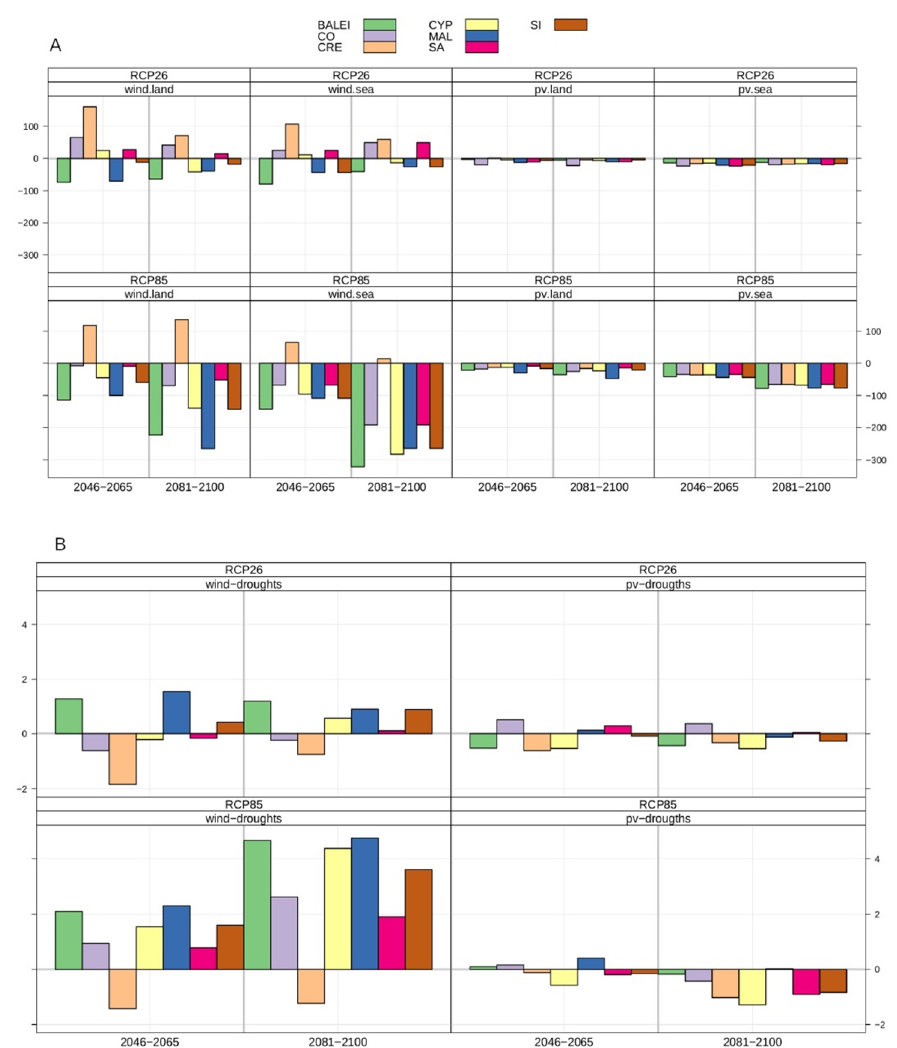
Figure 3. ( A ) Ensemble mean changes of annual wind (solar) productivity in absolute terms (kWh/kW) for the RCP2.6 and RCP8.5 scenarios and different periods over the sea and over the land. ( B ) Ensemble mean changes of annual wind (solar) productivity droughts in absolute terms (i.e., future minus control, in %) for RCP2.6 and RCP8.5 and the different periods. Each color represents an island/region (BALEI: Balearic Islands; CO: Corsica, CRE: Crete; CYP: Cyprus; MAL: Malta, SA: Sardinia, SI: Sicily).